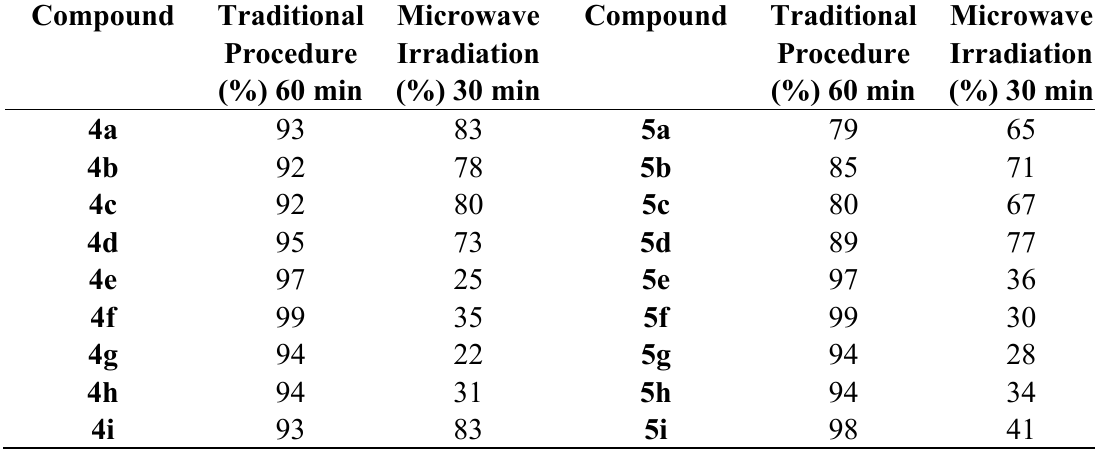
Table 2. Thiosemicarbazide yields and reaction times using microwave irradiation and stirring at room